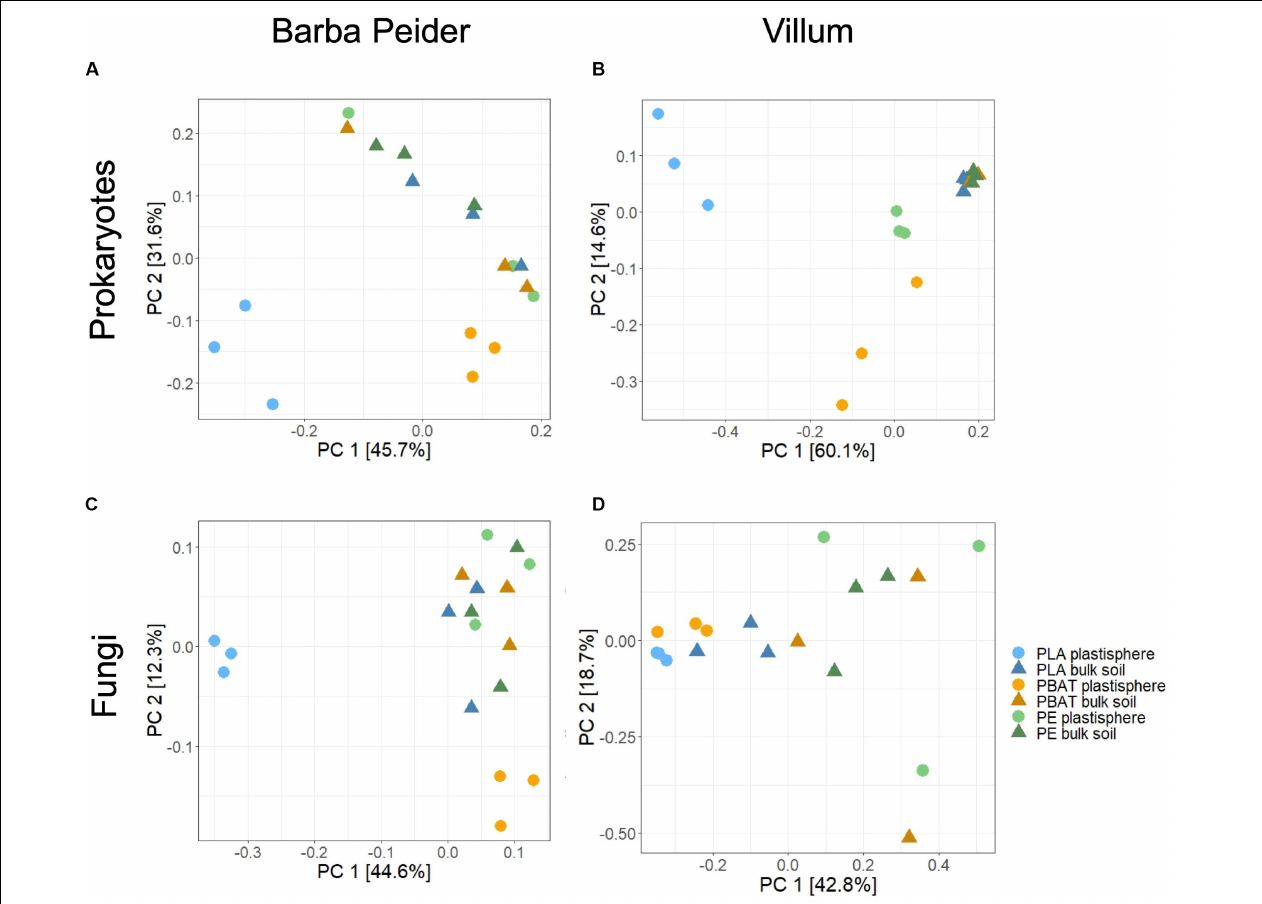
FIGURE 3 | Differences in β -diversity between plastisphere and bulk soil samples of the three plastic types, visualized by principal coordinate analysis (PCoA) based on Bray-Curtis dissimilarities. The variance explained by each PC axis is given in parentheses, and quantitative statistical results based on PERMANOVA are provided in Table 4 . Results are displayed for prokaryotes (A,B) and fungi (C,D) in Barba Peider (Swiss Alps) (A,C) and Villum (Northern Greenland) (B,D)